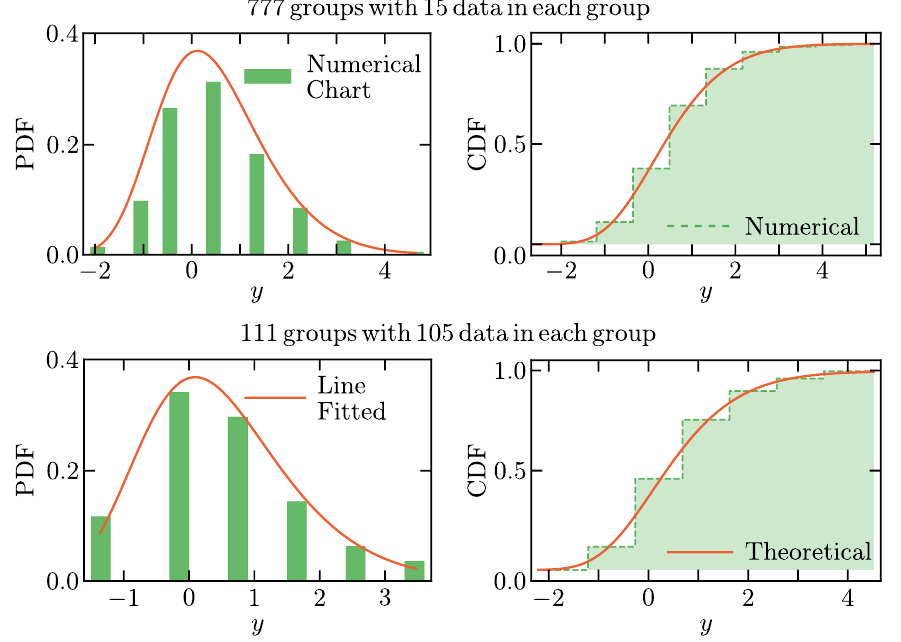
Figure 12 . Probability density function (PDF) and cumulative distribution function (CDF) of extreme maximum values of the vortex number spontaneously generated in the limit of fast quenches with τ Q = 20 . Independently of the partitioning size, he data is well described by a Weibull distribution with an upper